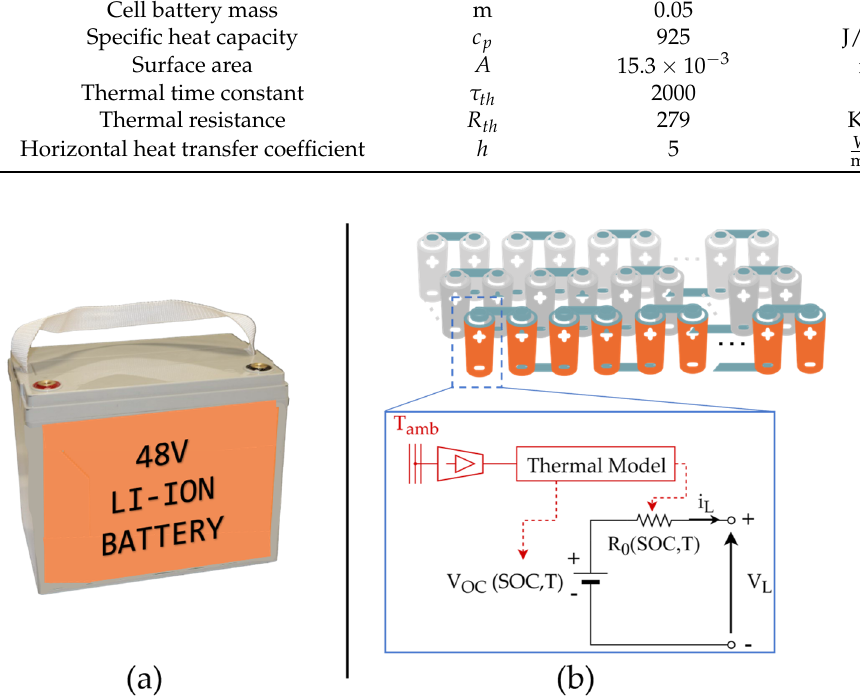
Figure 2. ( a ) 48 V Battery for the considered HEV; ( b ) equivalent electrical circuit including thermal modelling. The V OC and R 0 characteristics for the considered battery cell are reported in Figure 3.